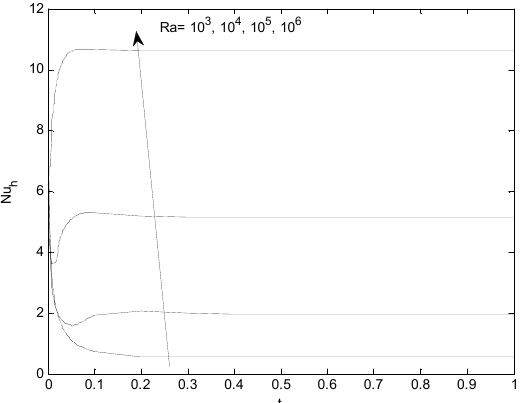
Figure 8. Time profiles of average Nu with Ra for κ = 1 and ε = 0.5.